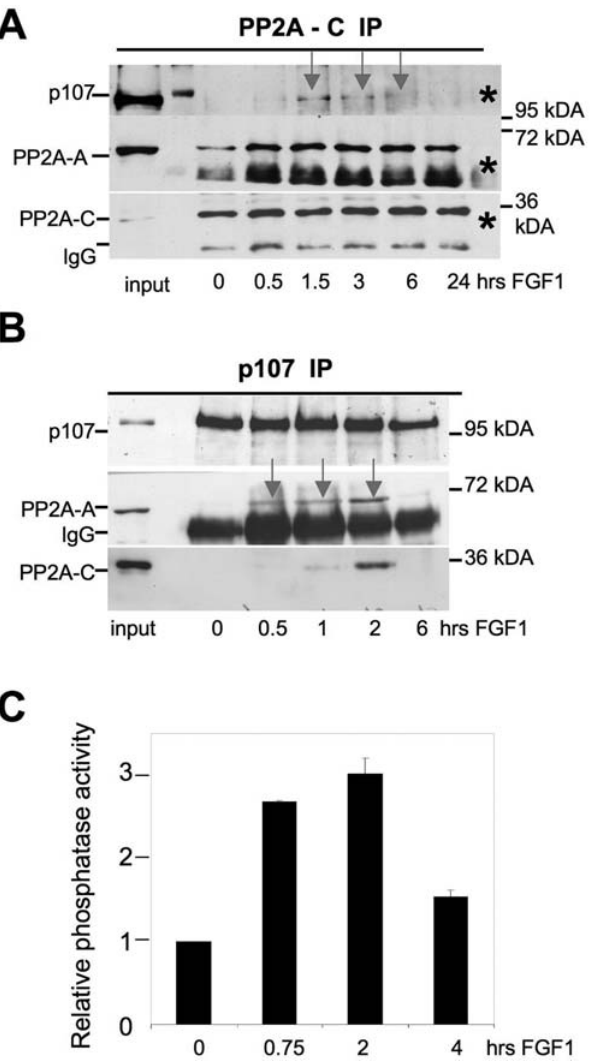
Figure 5. FGF induces an association between endogenous PP2A and p107. RCS cells were treated with FGF1 for the indicated periods of time. Lysates were prepared and normalized by the amount of total protein and subjected to immunoprecipitation with anti-PP2A-C (A) or anti-p107 agarose conjugated (B) antibody as described in Materials and Methods. 10% input and 50% IP samples were analyzed by WB with anti-PP2A-C, anti-PP2A-A or anti-p107 antibody. Control immunoprecipitation (*) was done using agarose A beads. (C) p107 immunoprecipitates from untreated and FGF treated RCS cells were used in in vitro Ser/Thr phosphatase assay. The background (protein A Sepharose without antibodies) was subtracted from initial counts and this value was normalized to one in the absence of FGF treatment. (Fig. 5B). Interestingly, the association of PP2A with p107 induced by FGF is transient, and is almost undetectable after 6 hours of FGF treatment. This coincides with the increase in phosphatase activity that coimmunoprecipitates with p107 in FGF-treated cells, that also subsides at that time (Fig. 5C). This finding suggests that, although p107 is dephosphorylated rapidly and remains dephos- phorylated for more than 24 hours after FGF treatment, the association of PP2A with p107 is transient and is no longer required to keep p107 in an hypophosphorylated state at later times, possibly because FGF signals are downregulated and/or the